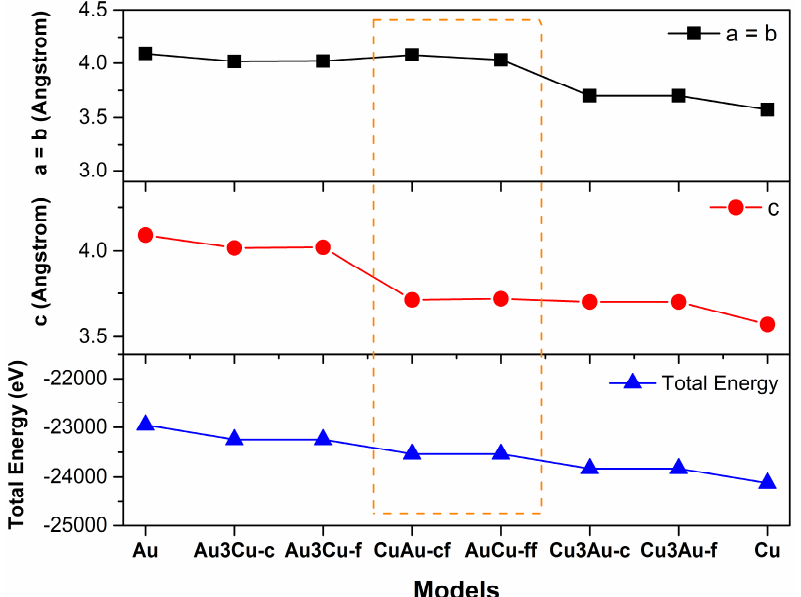
Figure 3. Optimized lattice constants and total energies for different systems of Au, Au3Cu, AuCu, AuCu3, and Cu materials were calculated using LDA-PWC.